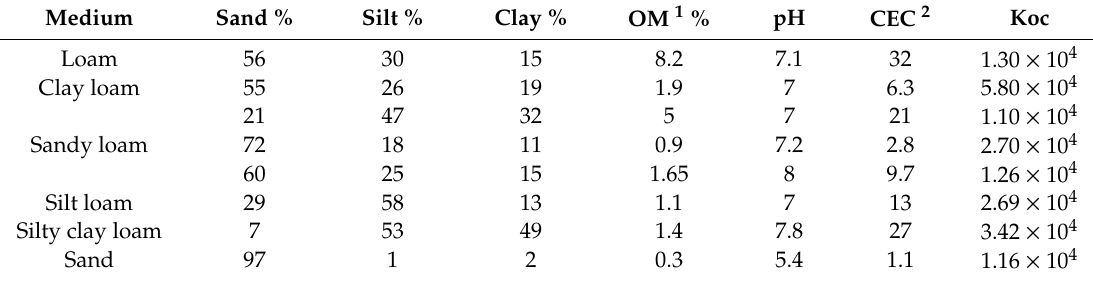
Table 3. Koc values of pyriproxyfen in di ff erent soils and sand (adapted from [21]).